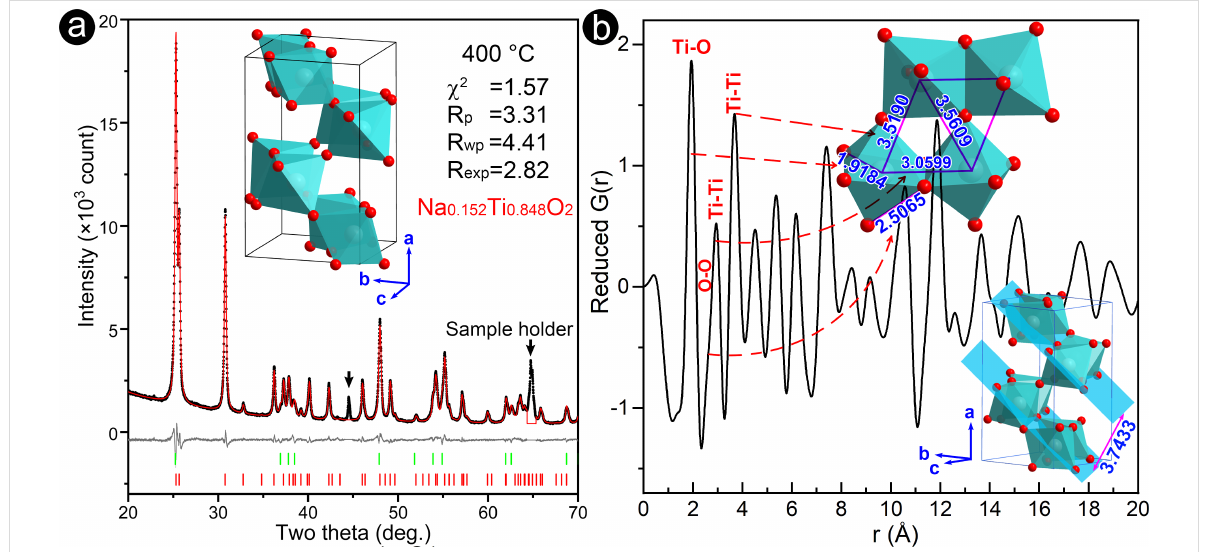
Figure 5: (a) A typical Rietveld refinement of the X-ray diffraction pattern of the sample calcinated at 400 °C. The positions of the Bragg reflections are indicated by vertical bars (red for Na 0.152 Ti 0.848 O 2 and green for the anatase). The difference between the experimental (black dots) and the calculated (solid line) intensities is shown by the plot in the lower part of the pattern. (b) The reduced atomic pair distribution function G ( r ) extracted from the ring-like electron diffraction pattern, where the inset illustrates the local atomic structures of